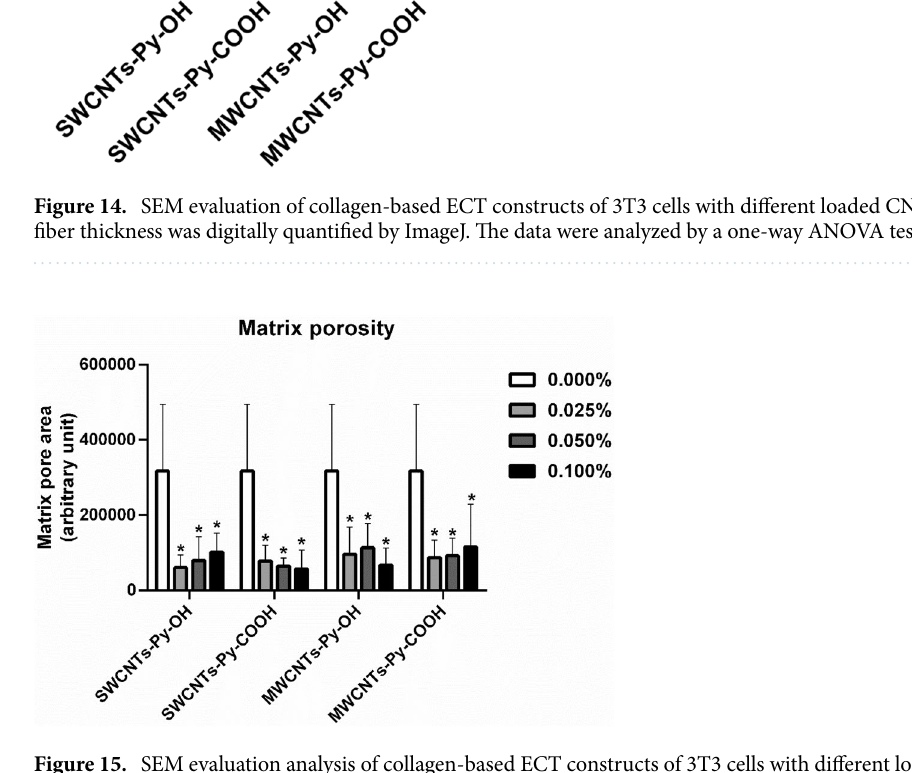
Figure 15. SEM evaluation analysis of collagen-based ECT constructs of 3T3 cells with different loaded CNTs. The symbol * indicates significance ( P ≤ 0.05) compared to the control (0.000%). The statistical significance was determined by one-way ANOVA, n = 12. Matrix porosity was digitally quantified by